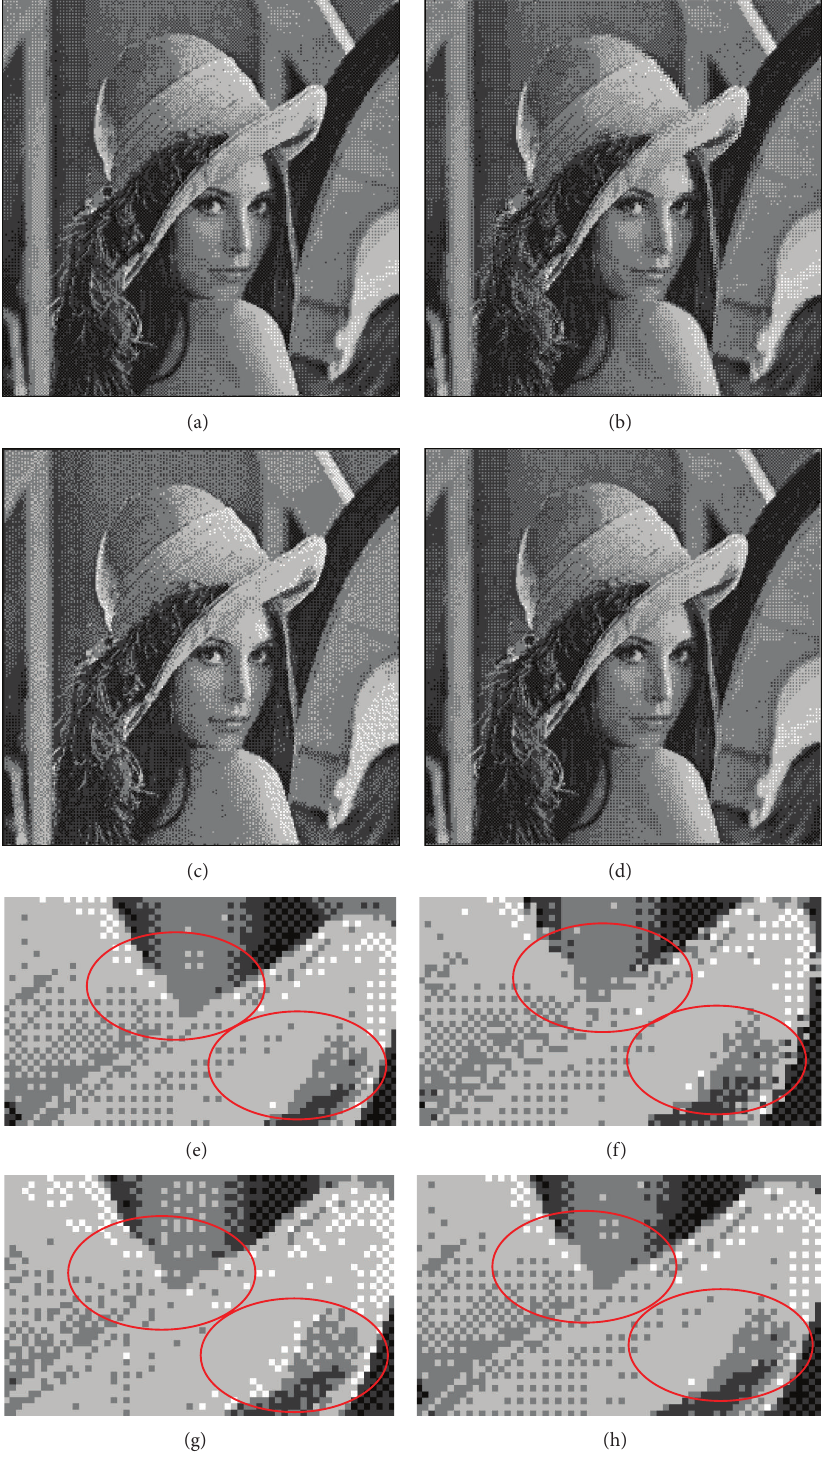
Figure 7: Visual quality comparison with 128 embedding bits when 𝑛 = 4 . (a) Original dithered image. (b) Embedded dithered image using Guo et al.’s method [12]. (c) Embedded dithered image using Hagit’s method [13]. (d) Embedded dithered image using the proposed method. (e) Enlarged partial image of (a). (f) Enlarged partial image of (b). (g) Enlarged partial image of (c). (h) Enlarged partial image of